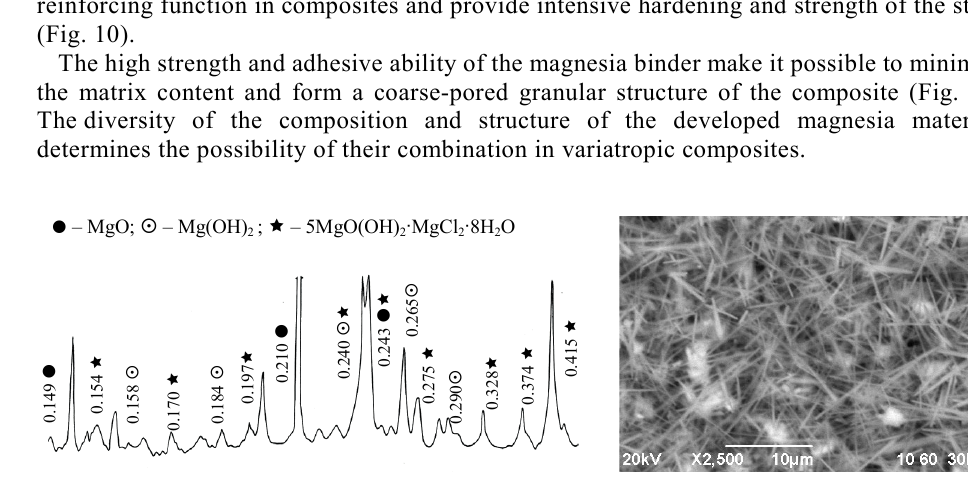
Fig. 9. Radiograph of magnesia stone. Fig. 10. Microstructure of magnesia